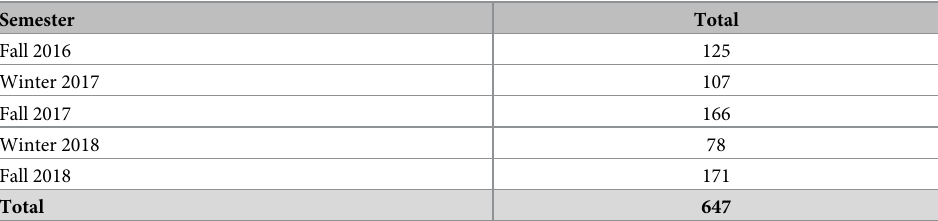
Table 1. Course enrollment by